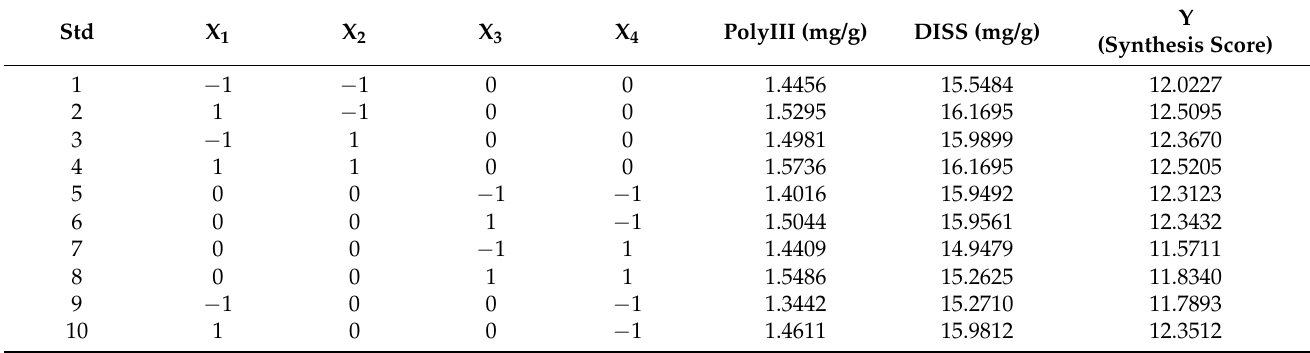
Table 2. Box-Behnken design (BBD) and